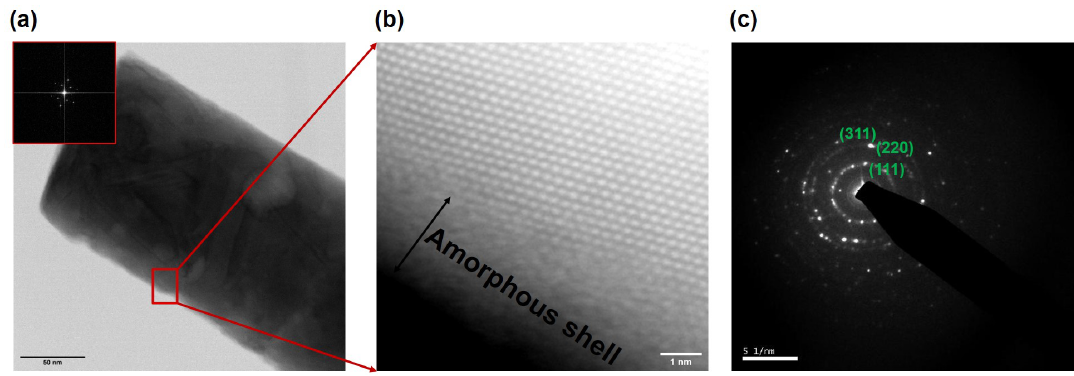
Figure 7. A scanning transmission electron microscope (STEM) images is taken along a single InSb nanowire clearly showing the presence of an amorphous oxide shell: ( a ) Annular bright-field (ABF)-STEM image of a relatively smooth nanowire that shows several crystal grains; the inset shows a fast Fourier transform (FFT) of the image indicating multiple crystallographic orientations; ( b ) magnified high-angle annular dark-field (HAADF)-STEM image of outlined region in ( a ), looking down the (111) direction of one of the larger grains, with a measured distance of 0.25 nm; ( c ) selected area diffraction pattern (SAED) shows indexed rings with discrete spots confirming polycrystalline nature of the